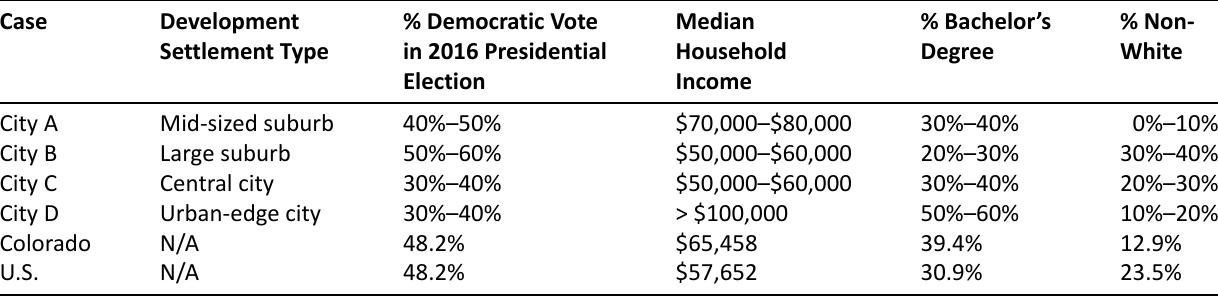
Table 1. Characteristics of case cities.